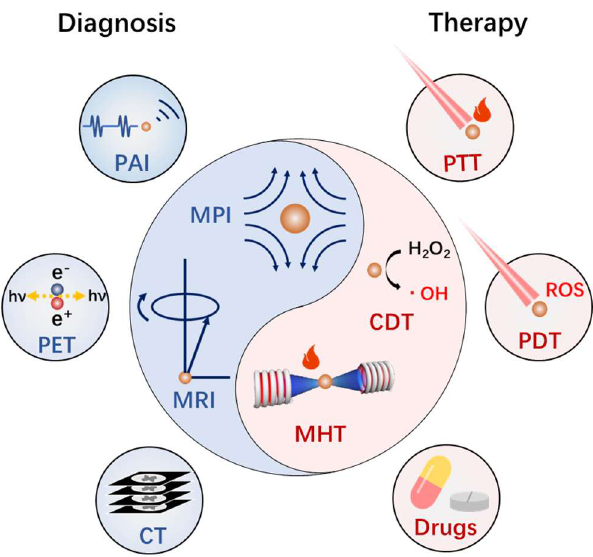
Figure 1. Diverse diagnosis and treatment technologies based on functionalized MIONs.